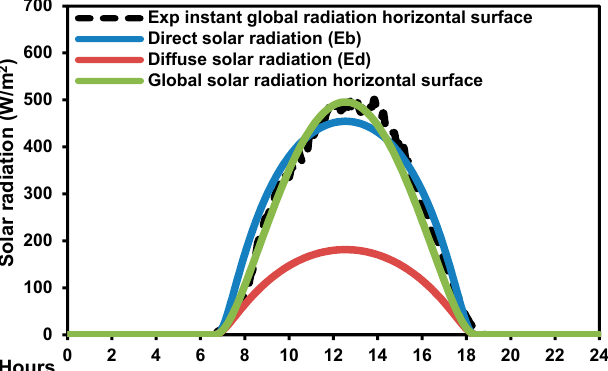
Figure 4. Solar radiation data for the 15th of March.